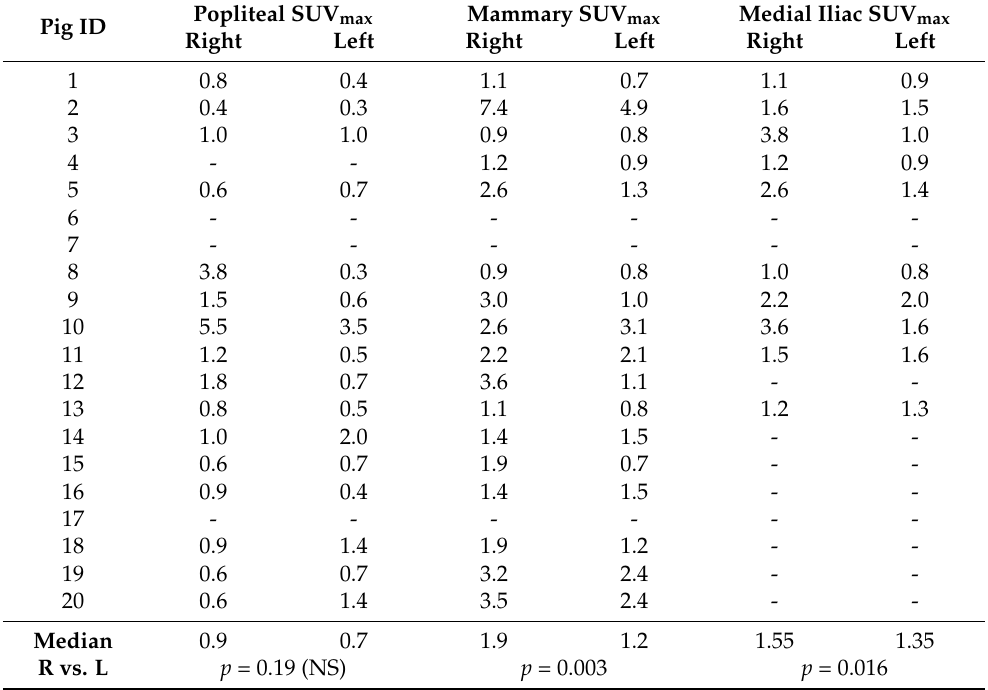
Table 3. Maximum Standardized Uptake Values (SUV max ) of [ 18 F]FDG in lymph nodes.